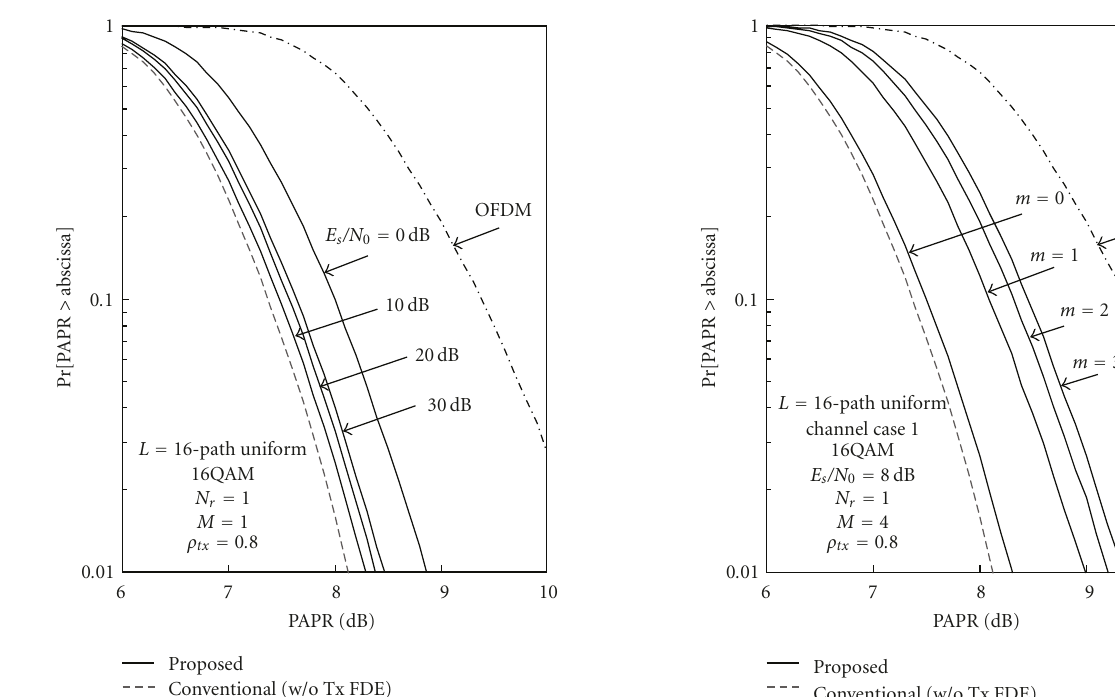
region is not observed. This is because, due to the lower frequency-diversity gain, the 1st retransmission is not always su ffi cient for correct packet